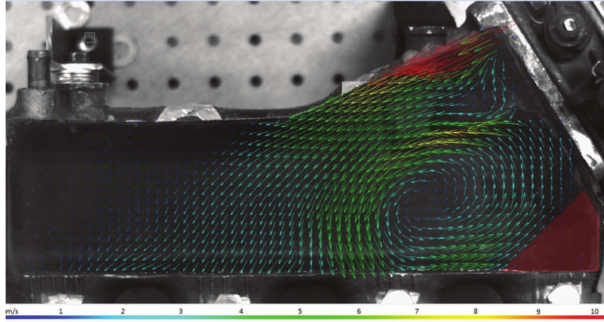
Fig. 13. Velocity vector distribution and air flow direction in the intake manifold at 2000 RPM engine speed and 30˚ throttle position angle